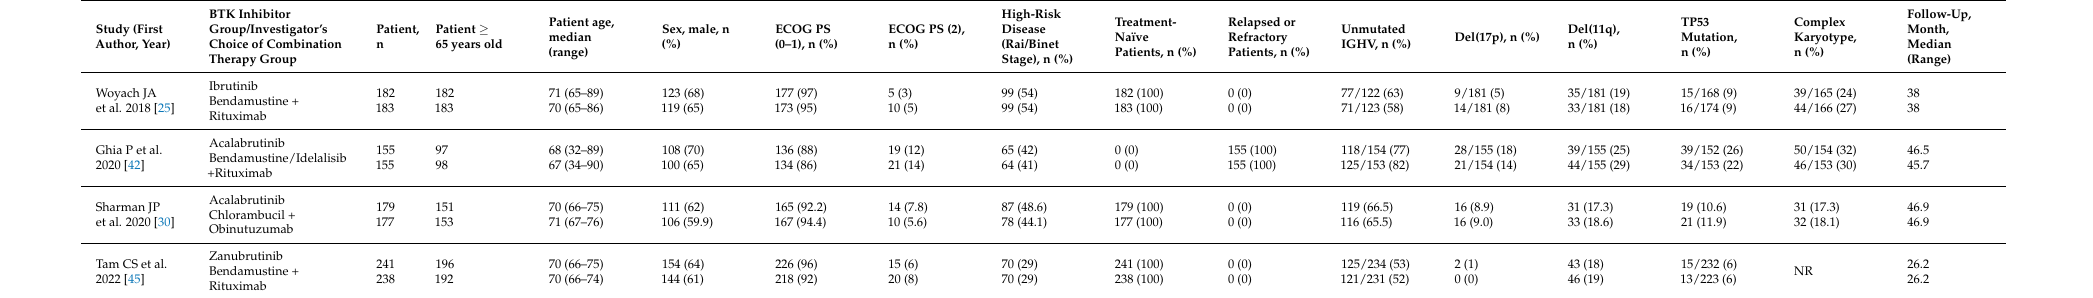
Table 2. Characteristics of patients included in the